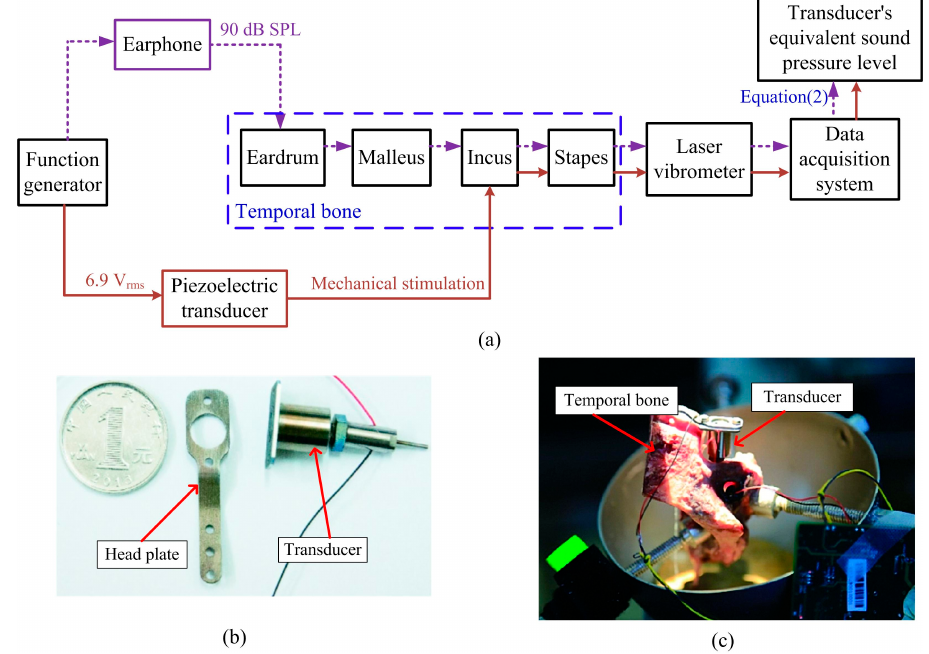
Figure 3. Flow diagram and pictures of the temporal bone experiment. ( a ) flow diagram of the temporal bone experiment (the solid arrow-lines indicate the acoustic stimulation testing, and the dashed arrow-lines indicate the transducer’s stimulation testing); ( b ) picture of the fabricated piezoelectric transducer; ( c ) a close view of the transducer implanted in the temporal bone.